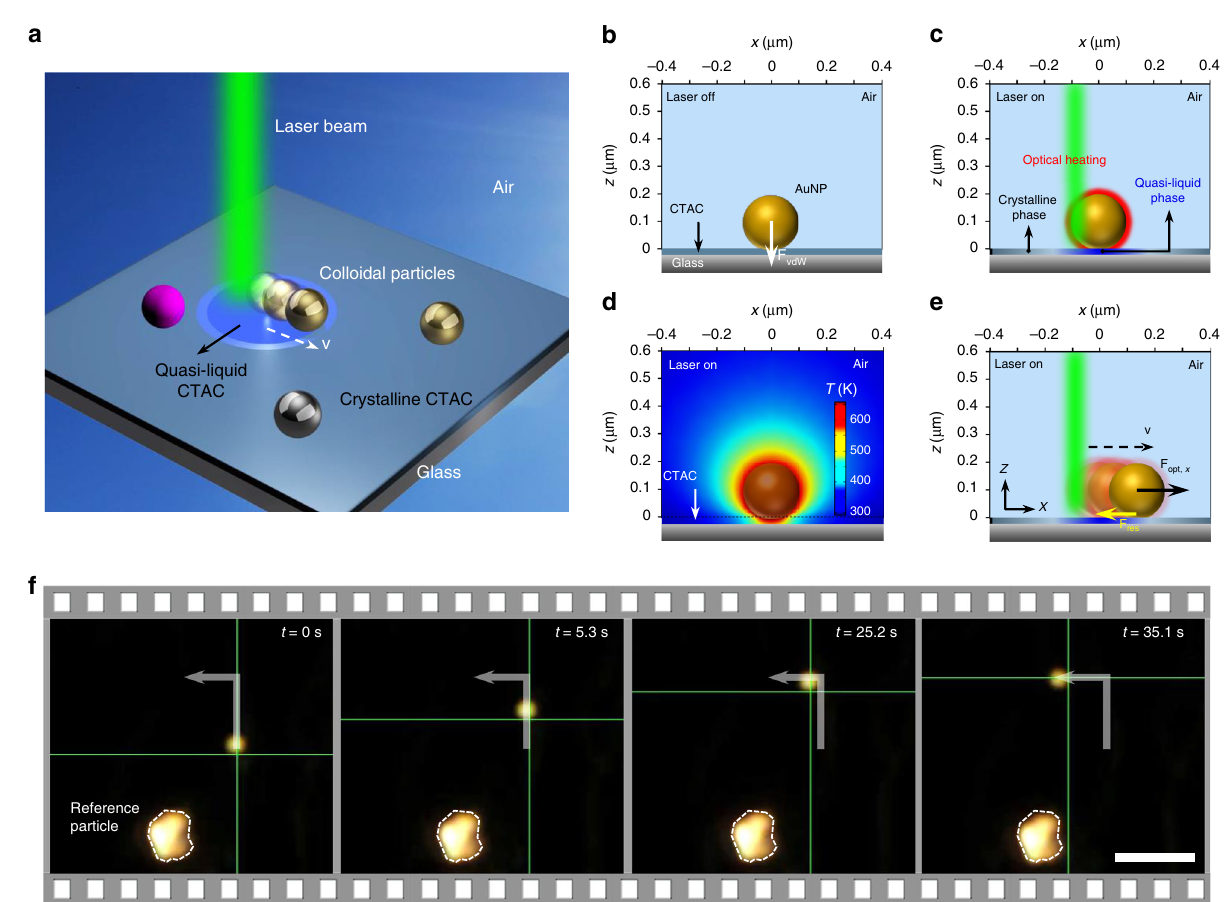
Fig. 1 General concept of OPN. a Schematic illustration of OPN on a solid substrate. b A 200 nm AuNP placed on and bonded with the CTAC layer by van der Waals force F vdW without optical heating. c The optical heating under laser illumination induces a localised phase transition in the surrounding CTAC layer. CTAC turns into a quasi-liquid phase and releases the bond with AuNP. d The simulated temperature distribution around a 200 nm AuNP. Incident power: 1 mW; laser beam size: 0.8 µ m. e AuNP moves against the laser beam with an in-plane optical force F opt, x and a resistant force F res . In a – e , the schematic con fi guration is fl ipped upside down for better visualisation. f Sequential dark- fi eld optical images showing real-time manipulation of a 300 nm AuNP. The green crosshair indicates the position of the laser beam. The white arrow depicts the path. Scale bar: 5 μ Fig. 2b. When the laser was on, the AuNP immediately gained an in-plane speed and moved in a direction against the laser beam.